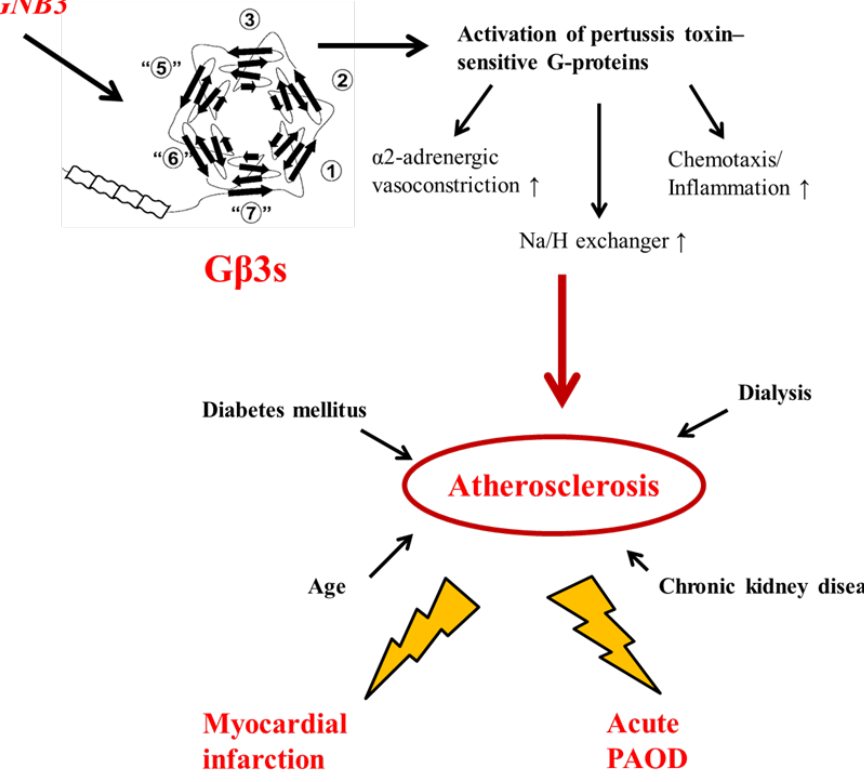
Figure 2. Impact of the GNB3 TT genotype on occurrence of acute cardiovascular events such as myocardial infarction and acute PAOD after renal allograft transplant. The 825T-allele of GNB3 leads to production of a truncated G β 3 molecule (G β 3s). The G β 3s induces increased activation of pertussis toxin-sensitive G-proteins that lead to enhanced α 2-adrenergic vasoconstriction, neutrophil chemotaxis response and subsequent potential activation of Na/H exchanger. Thus, the G β 3s might contribute to the accelerated development of atherosclerosis in renal allograft recipients. Besides of the presence of the TT genotype of GNB3 , other nonheritable factors such as age, chronic kidney disease, required dialysis treatment and concomitant occurrence of diabetes mellitus play an important role in formation of atherosclerosis in renal allograft recipients from our cohort. In combination with these above mentioned nonheritable factors, the presence of TT-genotype of GNB3 is associated with increased risk for acute myocardial infarction and PAOD after renal trans- plant.